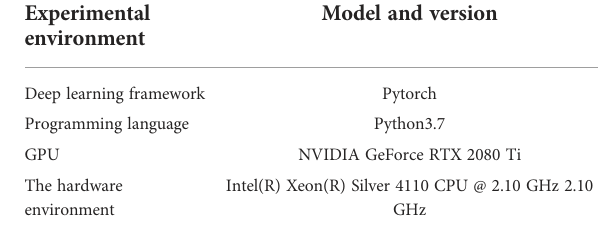
TABLE 1 Experimental con fi guration.